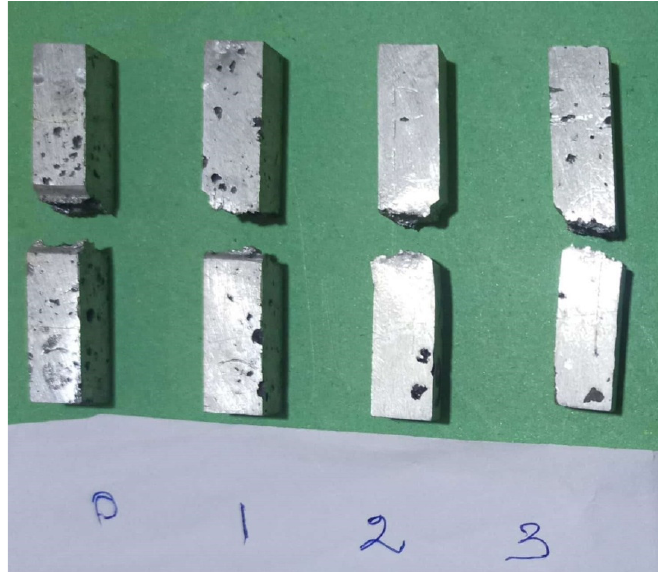
Figure 20. Fractured impact test specimens.